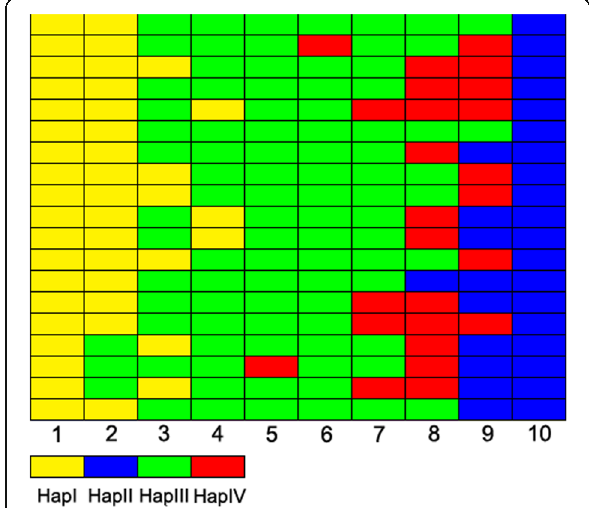
Fig. 6 Haplotype distribution of LOC _ Os06g39750 in RIL population . Every block represents a RIL, and all RILs are arranged according to their PSST value. 1, 2, 3, 4, 5, 6, 7, 8, 9, 10 column represent the RILs with PSST of 0.56~ 0.63, 0.63~ 0.67, 0.68~ 0.70, 0.70~ 0.72, 0.73~ 0.75, 0.75~ 0.77, 0.77~ 0.82, 0.82~ 0.85, 0.85~ 0.90, 0.90~ 0.95 from top block to bottom block, respectively. Yellow, blue, green, and red block represent HapI, HapII, HapIII, and HapIV,